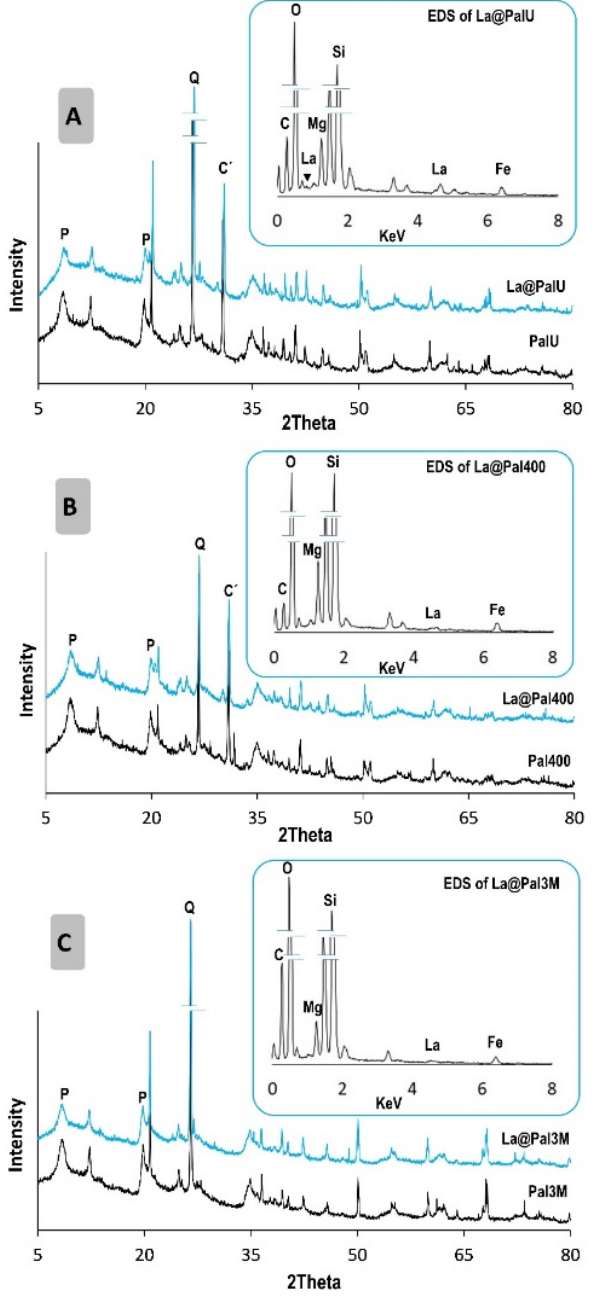
Figure 1. XRD of raw and modified palygorskite. ( A ) PalU and its modifications; ( B ) Pal400 and its modifications; and ( C ) Pal3M and its modifications. In the peak annotation: P = palygorskite, Q = quartz, and C’ = carbonate material. The EDS of only PalU is provided as the Supplementary Information SI Figure S4.